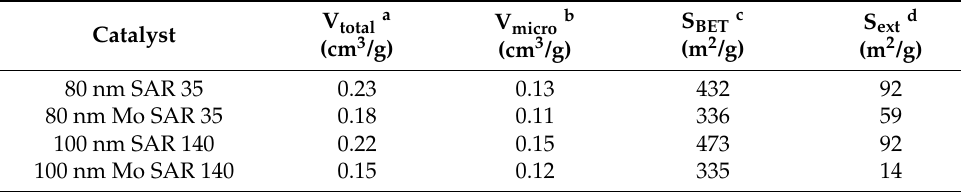
Figure 5. Morphologies and texture properties of seeded grown ZSM-5 with different sizes and SARs. EDS results for ( a ) 100 nm SAR 140; and ( b ) 80 nm SAR 35. Si, O, and Al are marked in red, sky blue, and yellow, respectively; ( c ) powder XRD patterns; and ( d ) N 2 isotherms of samples. The white horizontal scale bar represents 500 nm. Table 2. Texture properties of the seeded grown Al-ZSM-5 zeolite